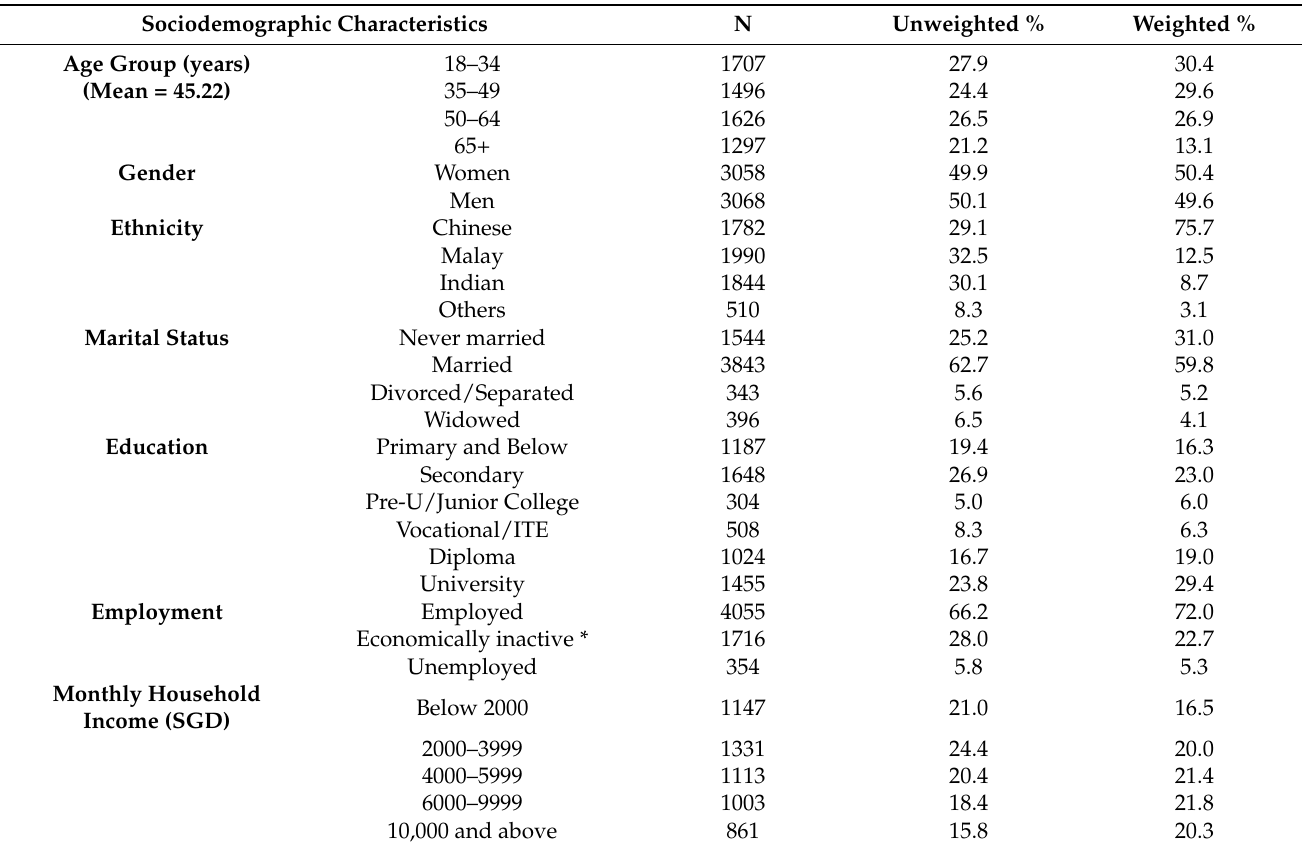
Table 1. Demographic characteristics of the SMHS 2016 Sample.